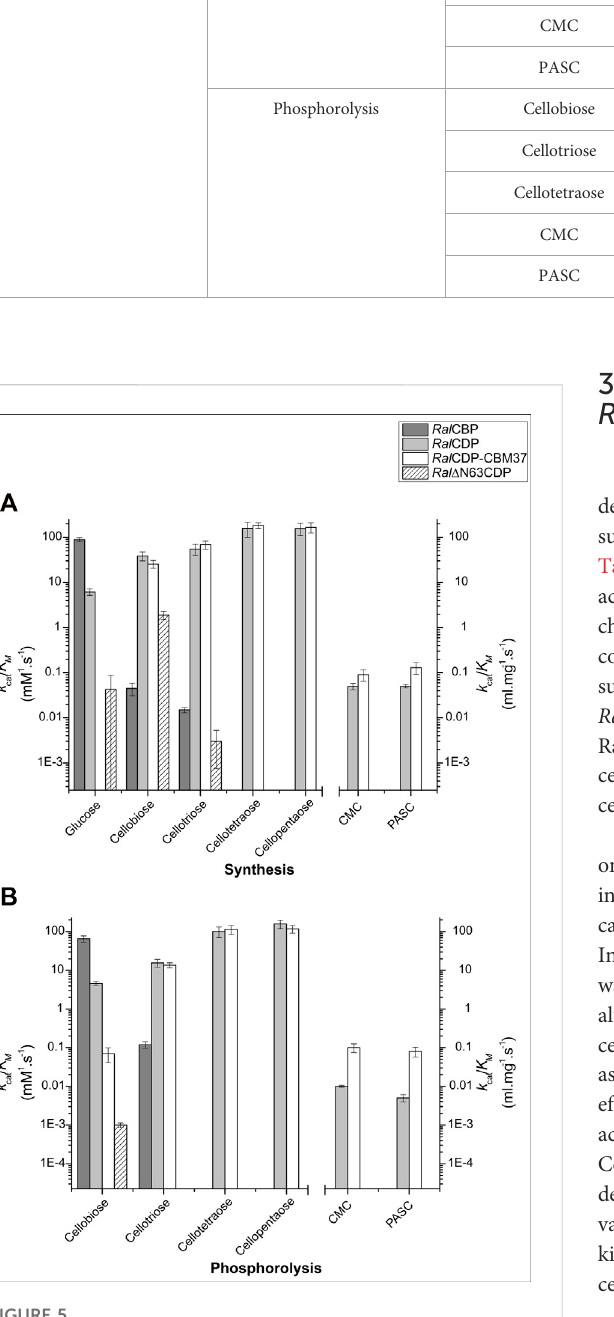
FIGURE 5 Enzymatic ef fi ciencies of Ral CBP (dark gray), Ral CDP (light gray), Ral CDP-CBM37 (white), and Ral Δ N63CDP (striped) with cello- oligosaccharides of different DP for synthesis (A) and phosphorolysis (B)